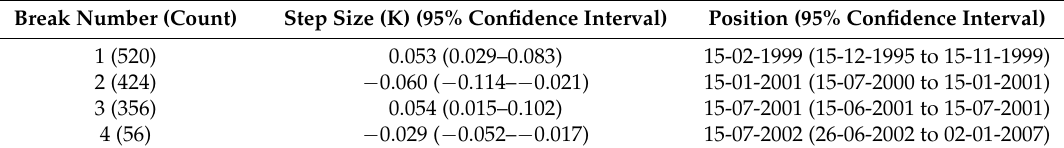
Table 6. Identified step changes, size and dates for the drifting buoy analysis. The 95% confidence intervals have been estimated based on the 2.5% and 97.5% quantiles of the step sizes and dates.